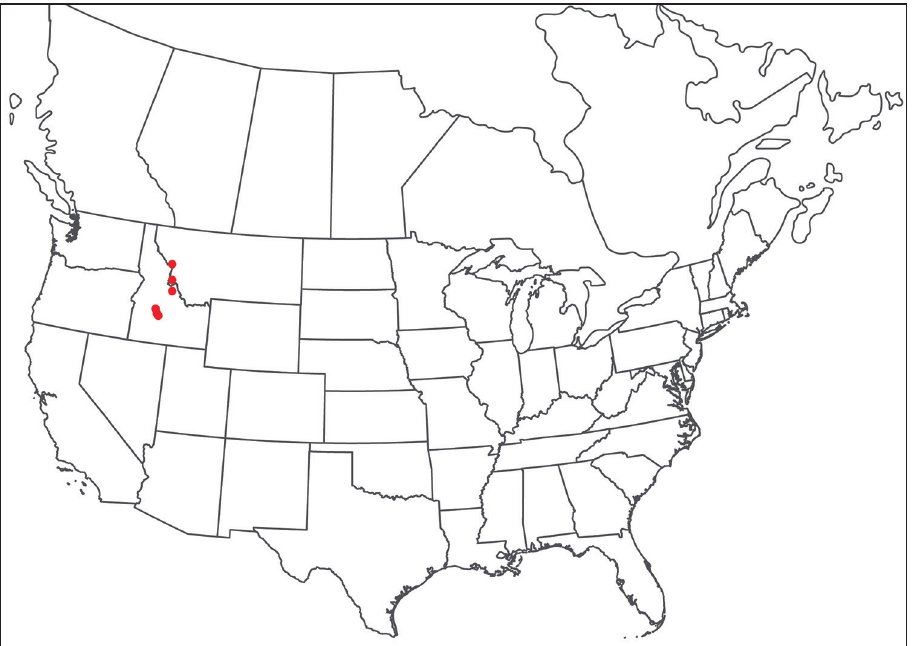
Figure 225. Torrenticola rockyensis sp. n.